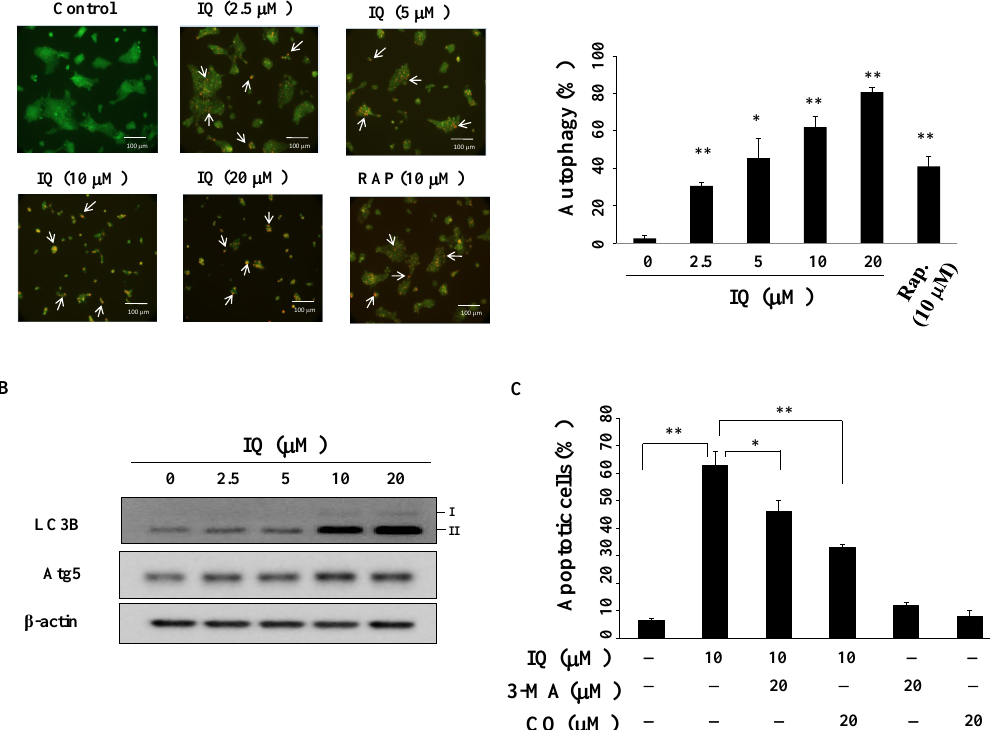
Figure 5. Ilimaquinone (IQ) induces autophagy. ( A ) Left panel, SCC4 cells were treated with DMSO vehicle, IQ, or rapamycin (RAP) for 24 h, harvested and stained with acridine orange, and examined under a fluorescence microscope; arrows, acidic vesicular organelles (AVOs). Right panel, statistical analysis of AVOs in IQ-treated SCC4 cells. Columns, mean; bars, S.D. ( n = 3). * p < 0.05 and ** p < 0.01 vs. the control group. ( B ) LC3B-II and Atg5 expression in SCC4 cells after IQ treatment for 48 h. ( C ) SCC4 cells were pretreated 20 µ M of 3-methyladenine (3-MA) or 20 µ M of chloroquine (CQ) for 15 min, followed by incubation with 10 µ M IQ for 48 h and dual staining with propidium iodide (PI) / annexin V- fluorescein isothiocyanate (FITC). Percentages in the graphs are representative of cell percentage in the respective quadrants ( n = 3). Columns, means; bars, S.D. * p < 0.05 and ** p <